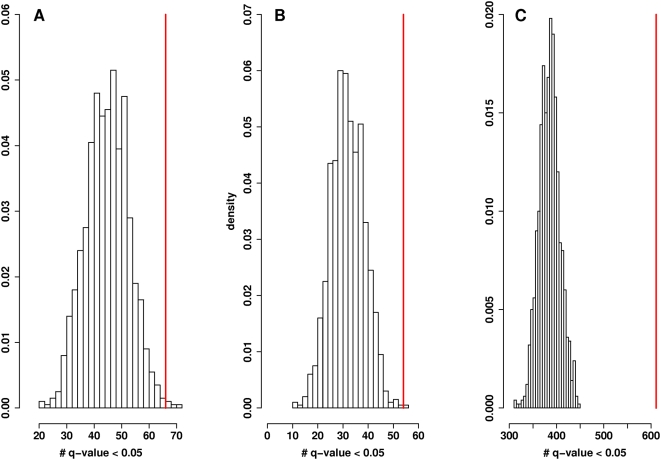
Significance of gene expression changes for longevity gene homologs and interacting proteins.The permutation distributions (based on 1,000 permutations of the array label) for the number of significant probes (based on FDR value in the association of age versus expression) for three different sets: A. human homologs of aging genes (based on 1,000 random draws of 291 probes), B. longevity gene homologs present in the interaction network (based on 1,000 random draws of 210 probes), and C. 1° interactor protein genes (based on 1,000 random draws of 2,507 probes). Vertical red lines indicate values (number of probes with FDR-based q-value<0.05) for the original experimental datasets from which the p-values of these three tests are derived.